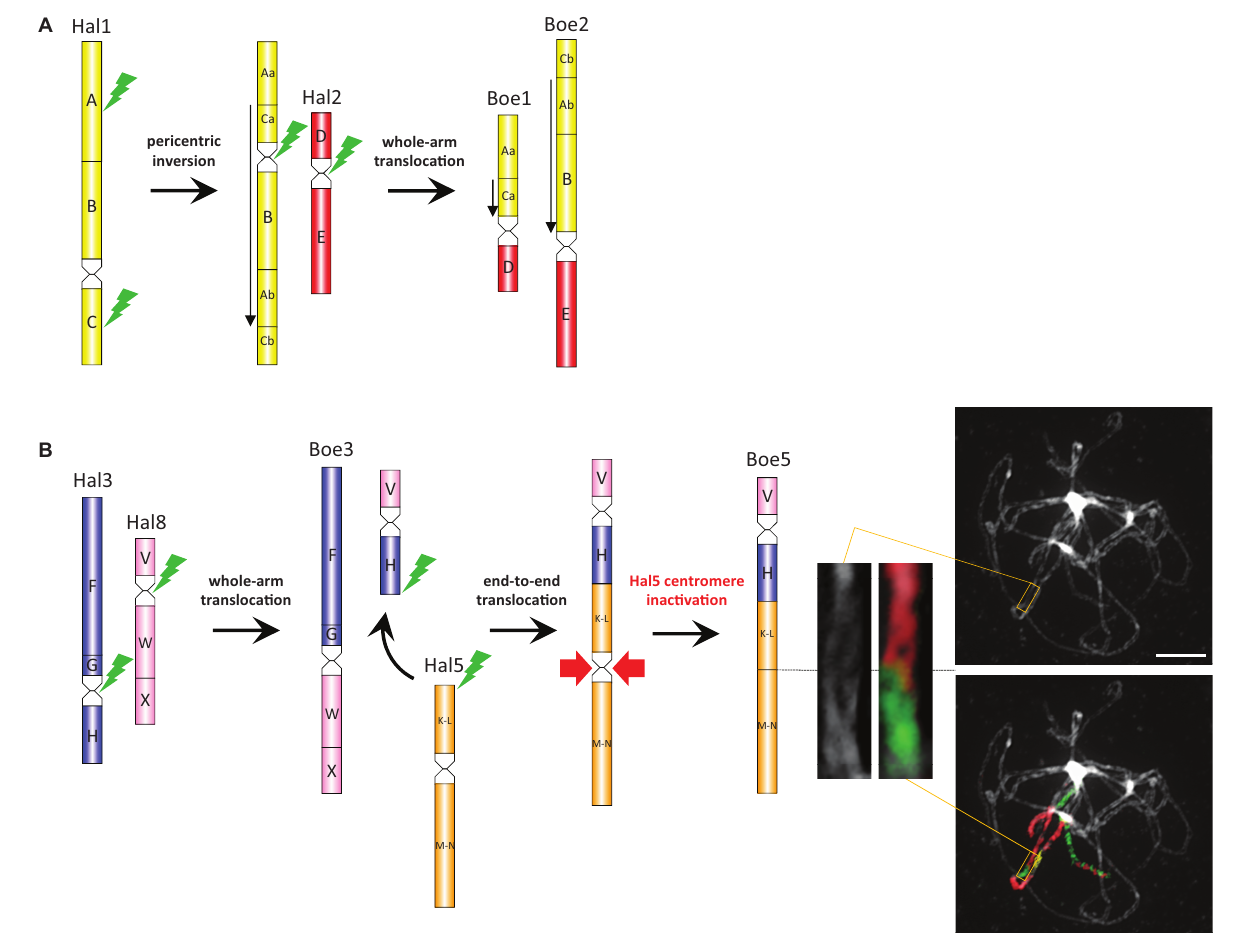
FIGURE 4 | The origin of Boechereae-specific chromosomes. Parsimoniously reconstructed origin of the ancestral Boechereae chromosomes Boe1, Boe2 (A) , Boe3, and Boe5 (B) from the ACK/Halimolobeae-like chromosomes Hal1–Hal3, Hal5, and Hal8. Chromosome images show painting of the Boe5 homeolog at pachytene in Boechera gracilipes including the K-L/M-N region with the inactive AK5 paleocentromere (magnified inset). Downward-pointing arrows refer to GBs inverted compared to their orientation in the ACK/Halimolobeae genome. Capital letters mark the ancestral GBs of the ACK (Lysak et al., 2016). Green flash-like symbols indicate chromosome breakpoints; red arrows indicate the lost of Hal5 (AK5) centromere on Boe5. Scale bar, 10 µ m.